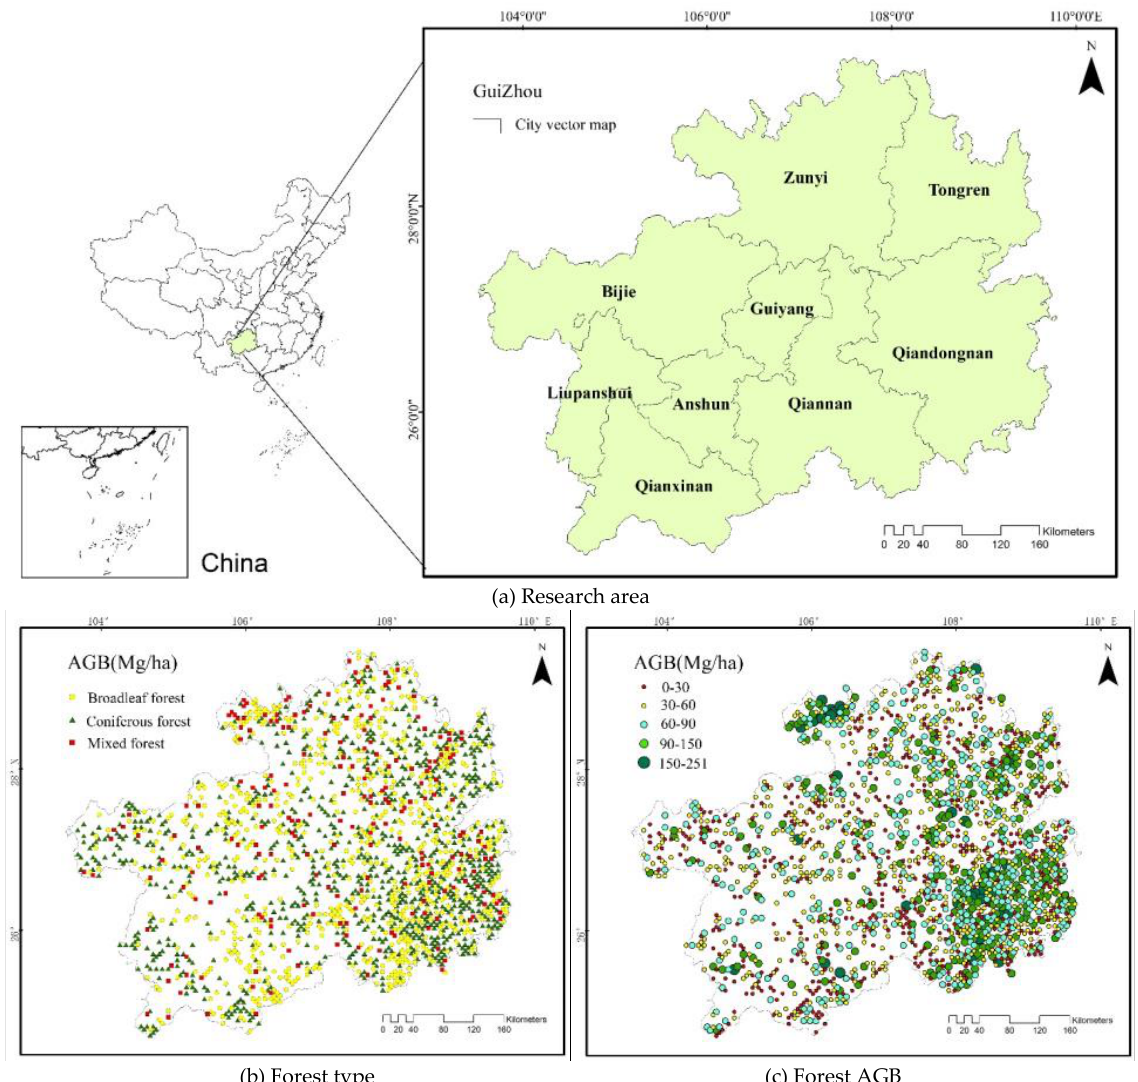
Figure 1. The research area and sample plot distribution in 2015 (( a ): research area, ( b ): forest type, ( c ): forest AGB).